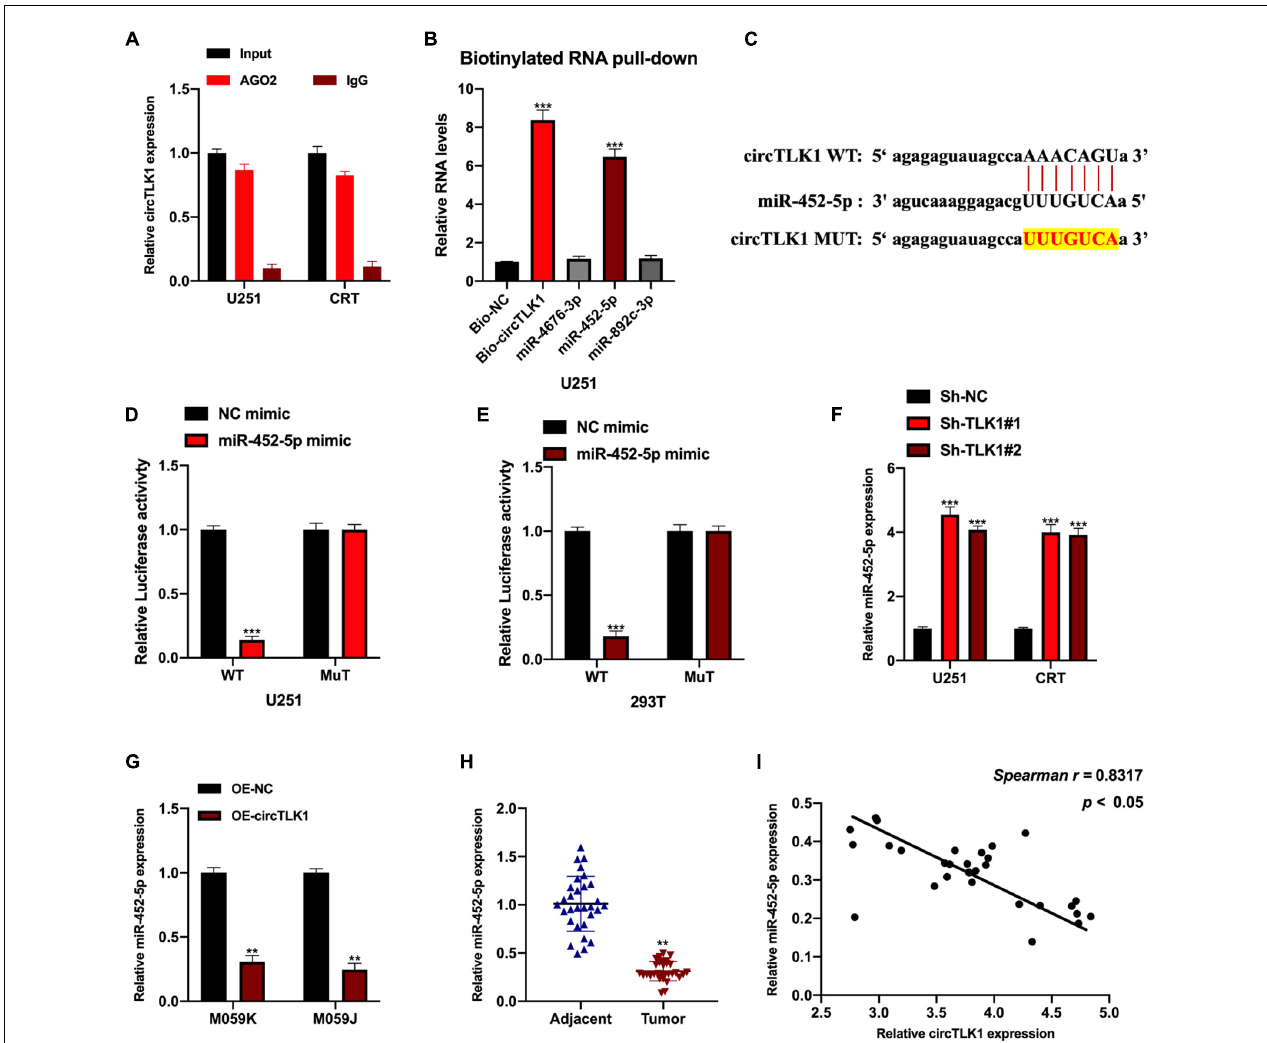
FIGURE 5 | CircTLK1 sponges to miR-452-5p. ENCORI database (http://starbase.sysu.edu.cn/index.php) with CLIP data, strict stringency ( ≥ 5), and degradome data, medium stringency ( ≥ 2) (A) mRNA binding ability of circTLK1 was detected using AGO2-RIP assays in U251 cells. (B) qRT-PCR was performed to assess relative RNA expressions in U251 cells. (C) The binding sites between miR-452-5p and circTLK1 (WT or MUT). (D,E) Relative luciferase activities in NC mimic, miR-452-5p mimic, and reporter vectors containing circTLK1 WT and Mut sequences transfected into 293T and U251 cells were measured. (F) Relative miR-452-5p expression in U251 and CRT cells pretreated with Sh-NC, Sh-circTLK1#1, and Sh-circTLK1#2 was measured using qRT-PCR. (G) miR-452-5p expression in U251 and CRT cells pretreated with OE-NC and OE-circTLK1 was evaluated using qRT-PCR. (H) The miR-452-5p expression level in glioma tissues was detected using qRT-PCR. (I) The circTLK1 and miR-452-5p expression association was calculated using Spearman analysis. **p < 0.01, ***p <